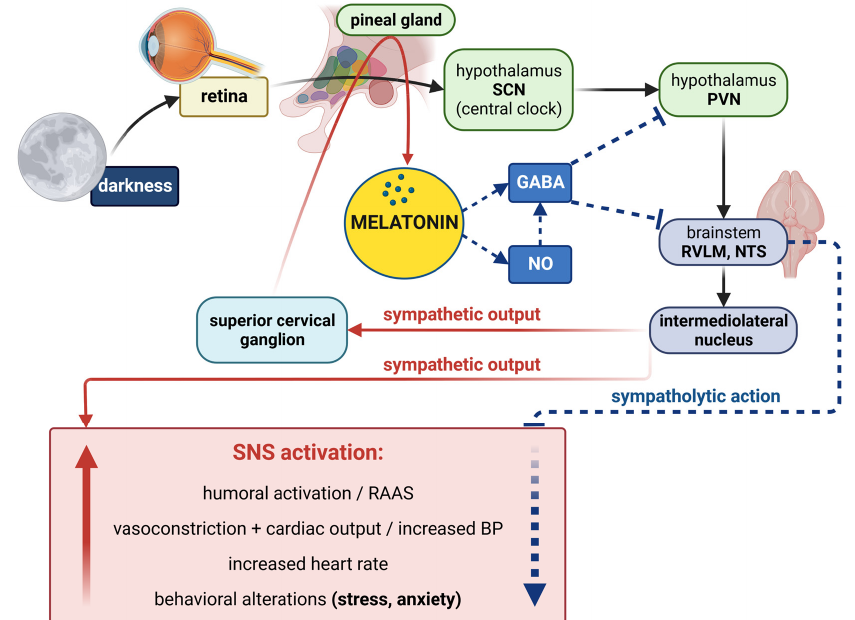
Figure 5. Interaction of the sympathetic nervous system (SNS) with melatonin. Darkness (the absence of light impulses) is the driver of melatonin synthesis and release. The retinohypothalamic tract leads from melanopsin-containing retinal neurons to the suprachiasmatic nucleus (SCN), which generates rhythmic oscillations. These impulses pass via the neurons of the paraventricular nucleus (PVN) of the hypothalamus and via the rostral ventrolateral medulla (RVLM) and nucleus of the solitary tract (NTS) to the upper thoracic intermediolateral cell column, which innervates the superior sympathetic ganglion, generating a sympathetic tone. The sympathetic impulses enhance the peripheral vascular tone and cardiac contractility with a blood pressure (BP) increase, and they activate additional humoral systems and induce behavioral changes. At the same time, the sympathetic impulses from the intermediolateral nucleus project to the superior cervical ganglia from where postganglionic fibers enter the pineal gland to stimulate melatonin production via beta and alpha-1 adrenoceptor activation by norepinephrine. Furthermore, melatonin released from the pineal gland can presumably exert a negative feedback effect on the central sympathetic system via enhancing γ -aminobutyric acid (GABA)ergic signaling, which is involved in the inhibition of PVN, RVLM and NTS. Melatonin also enhances nitric oxide (NO) availability, which potentiates the GABAergic inhibitory effects in the PVN and RVLM. Red arrows represent the sympathetic impulses and blue arrows represent the sympatholytic